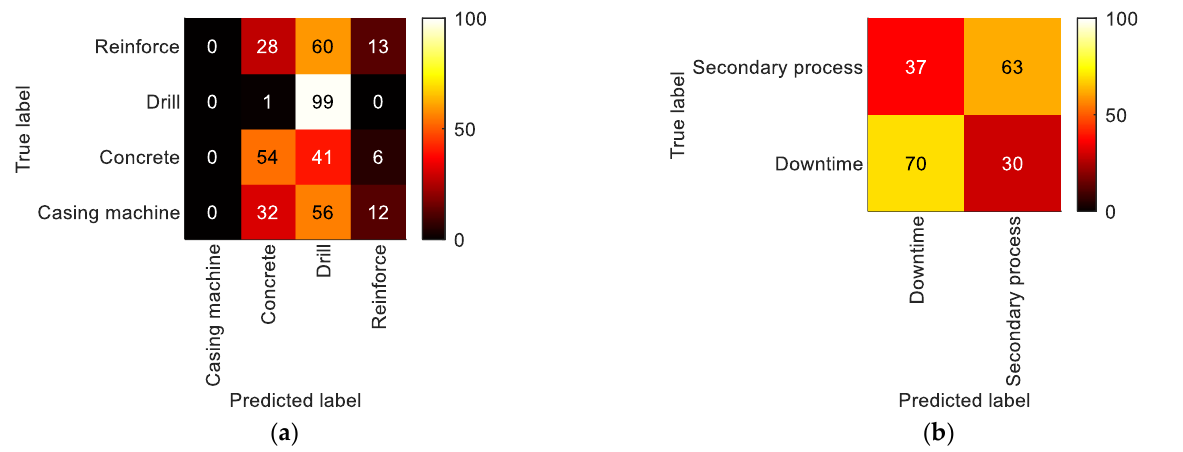
Figure A2. LoD2 confusion matrix for the MLP: ( a ) work; ( b ) idle.